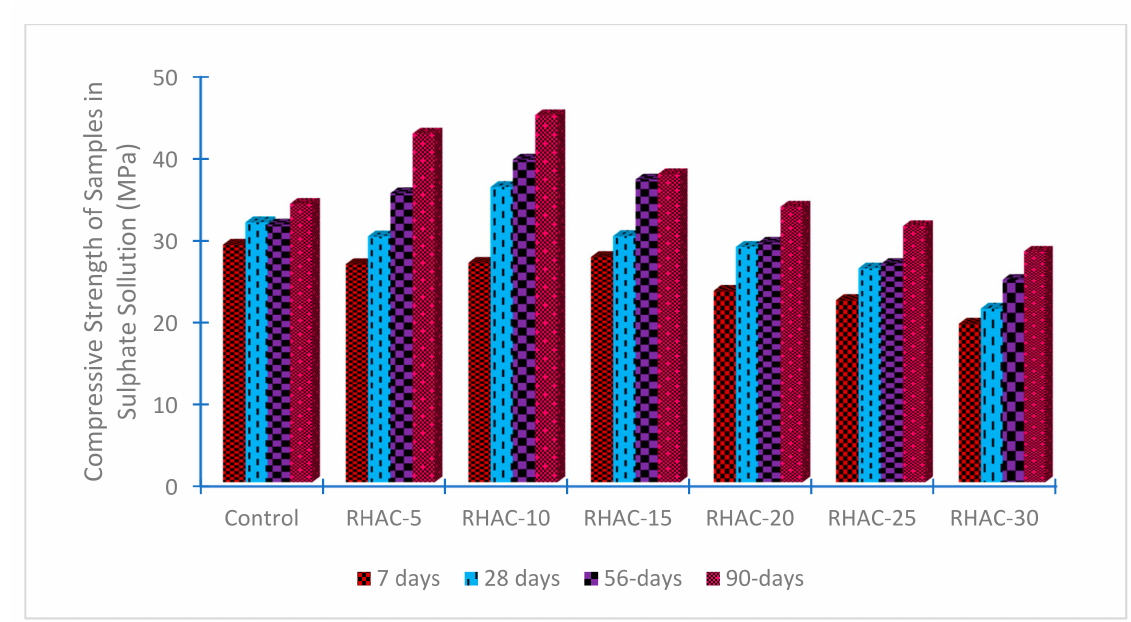
Figure 16. Compressive strength of RHA blended HPC cured in a sulphate environment.